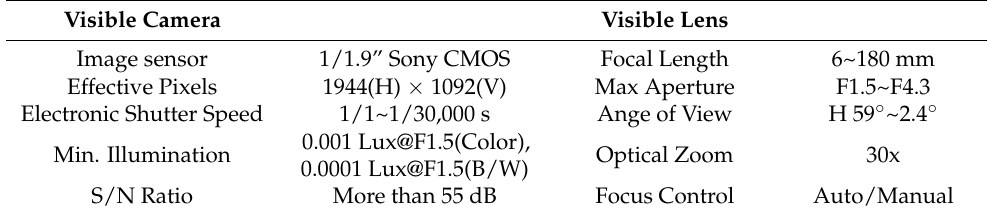
Table 2. Dahua DH-TPC-PT8620A-T technical